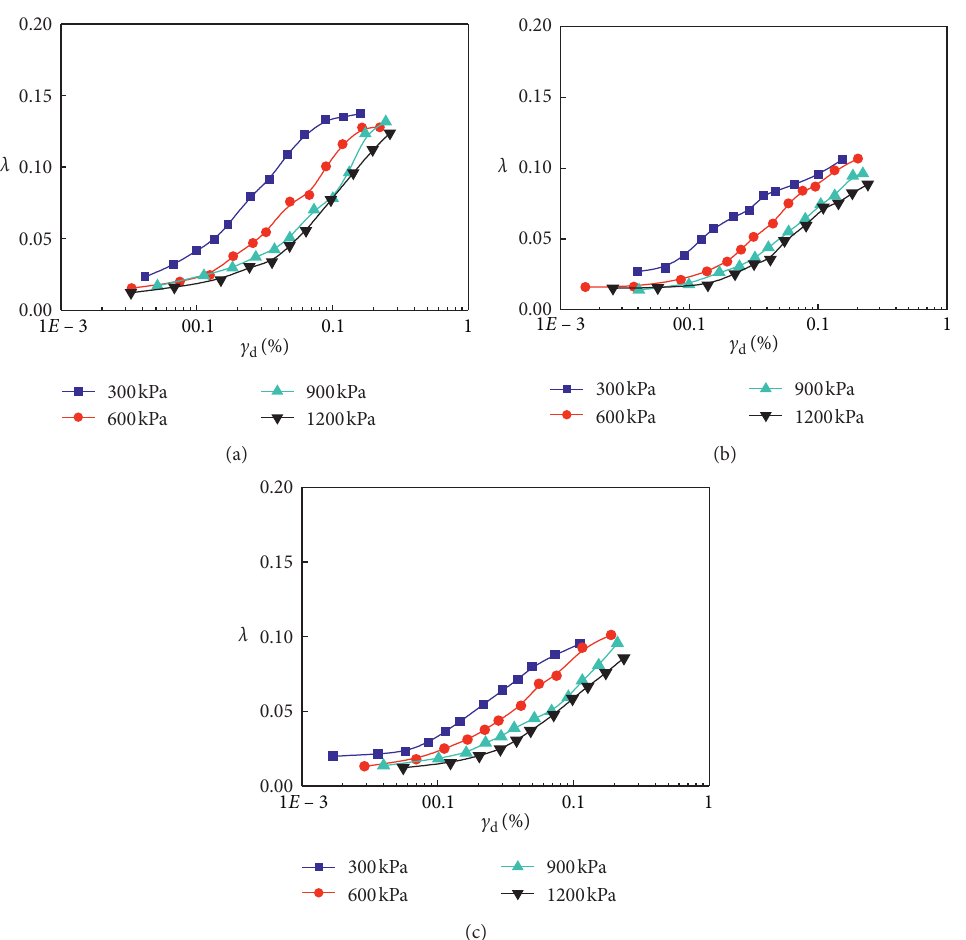
Figure 12: Damping ratio λ of the LCSG material under different cementing agent contents and according to changes in dynamic shear strain. (a) 40 kg/m 3 . (b) 60kg/m 3 . (c) 80 kg/m 3